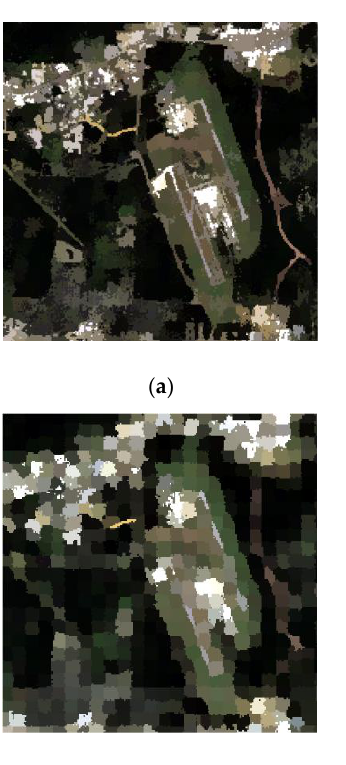
Figure 7. Results of different compactness parameters for GF-1 satellite imagery: ( a ) m = 10; ( b ) m = 20; ( c ) m = 30; ( d ) m = 40.